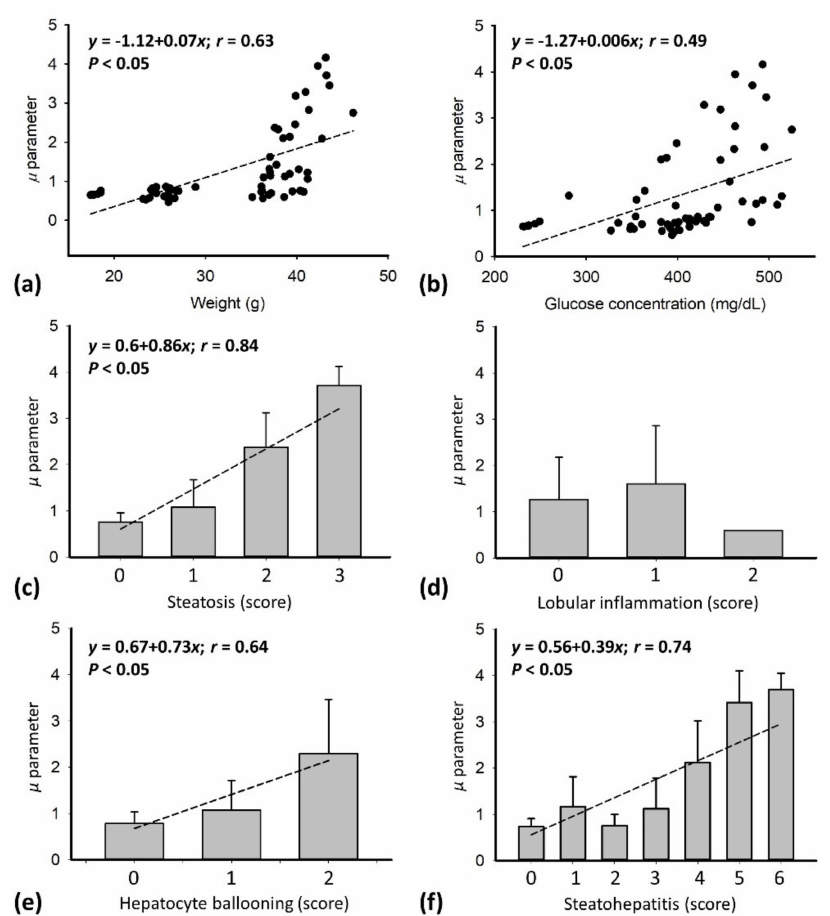
Figure 5. HK µ parameters as functions of MetS and histopathological scores (across all groups). The Spearman correlation coefficient was calculated. ( a ) Body weight, ( b ) glucose concentration, ( c ) steatosis, ( d ) lobular inflammation, ( e ) hepatocyte ballooning, and ( f ) steatohepatitis. No correlation was observed in ( d